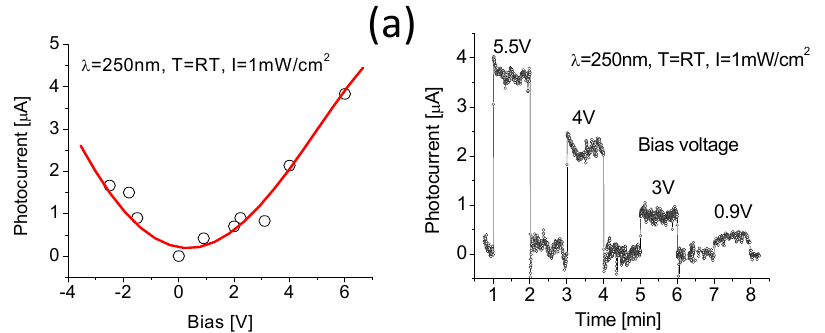
Figure 5. ( a ) Response of the DUV-PD as a function of the bias voltage magnitude; ( b ) time-dependent responses at di ff erent applied bias voltages with a fixed 250-nm light radiation intensity and operating temperature.